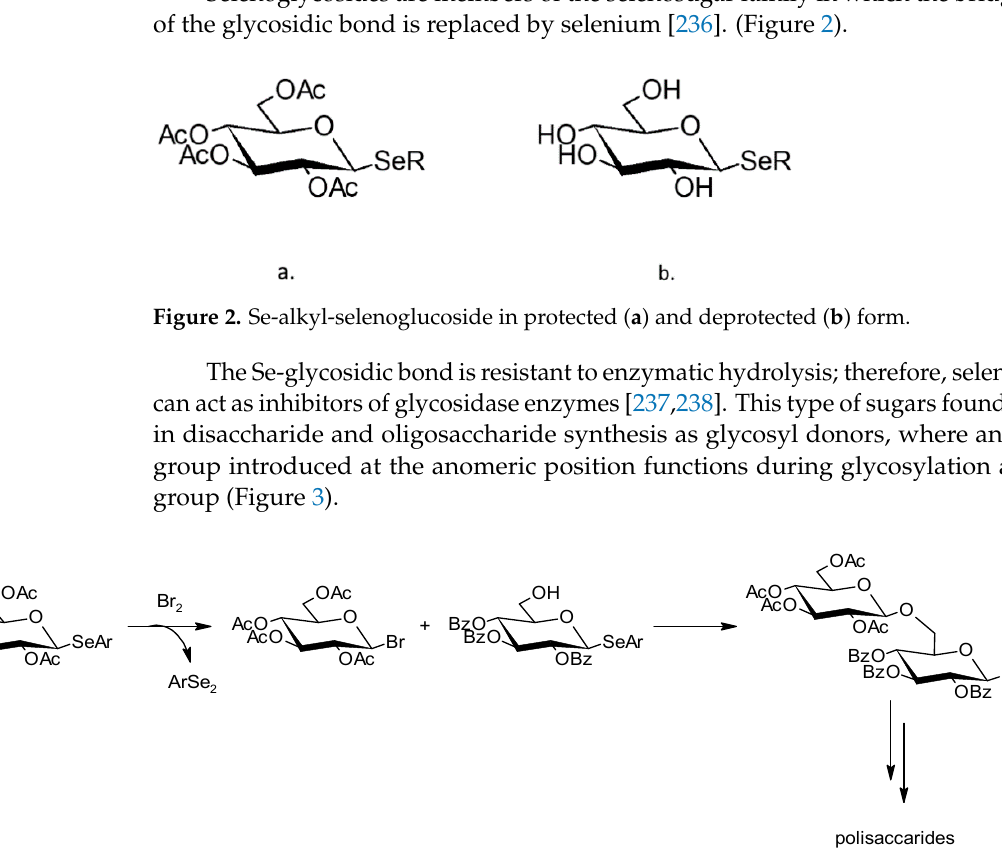
Figure 3. The application of selenoglycosides in polysaccharide synthesis. Bz—benzoyl group: C 6 H 5 C(O)-; Ac—acetyl group: CH 3 C(O)-.